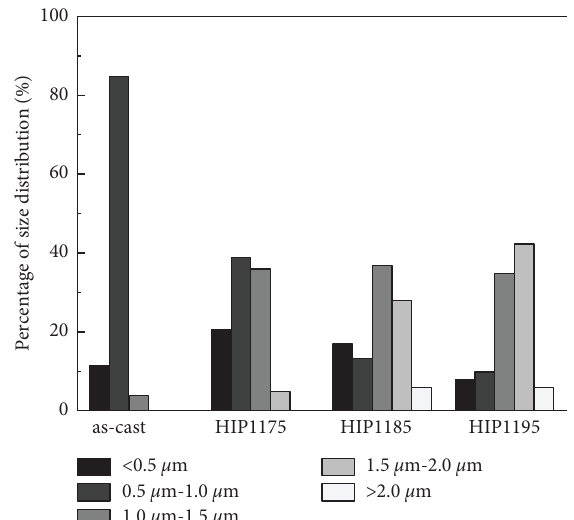
Figure 11: Size distribution of c ′ precipitates in diferent condi- tions of the K417G alloy.